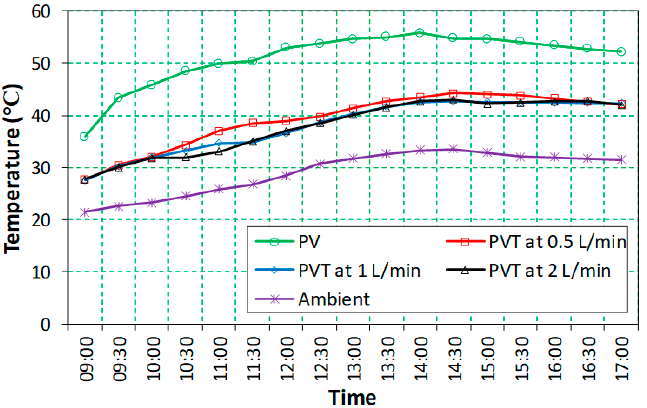
Figure 4. Changes in temperature at different flow rates for distilled water.